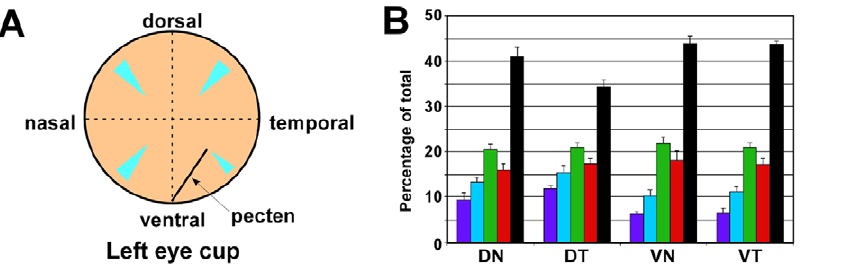
Figure 2. Cone photoreceptor types are present in characteristic ratios. (A) Diagram of a chicken eye cup showing the regions of the mid- peripheral retina (in light blue) from which all fields analyzed in this study were derived. (B) Percentages of cone types from each of four quadrants (n=7 fields for each quadrant). Data for violet, blue, green and red cones are colored accordingly. Data for double cones are shown in black. Error bars indicate SD.